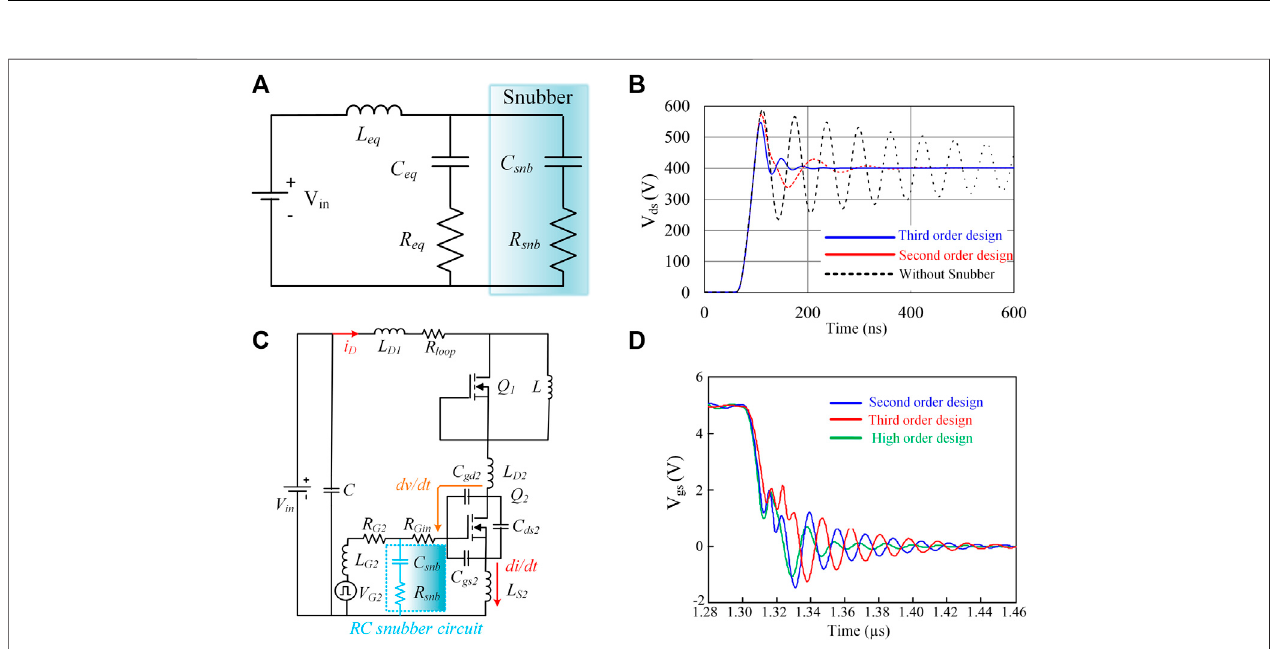
FIGURE8|(A) EquivalentRLCcircuitofDPTwithsnubberemployedacrossthephaseleg (B) Comparisonofdifferentdesignmethodsforoscillationattenuationin V ds (Yatsugi et al., 2018) (C) Circuit diagram of DPT with snubber employed in the gate loop (Chen et al., 2020) (D) Comparison of different design methods for false triggering mitigation (Chen et al.,